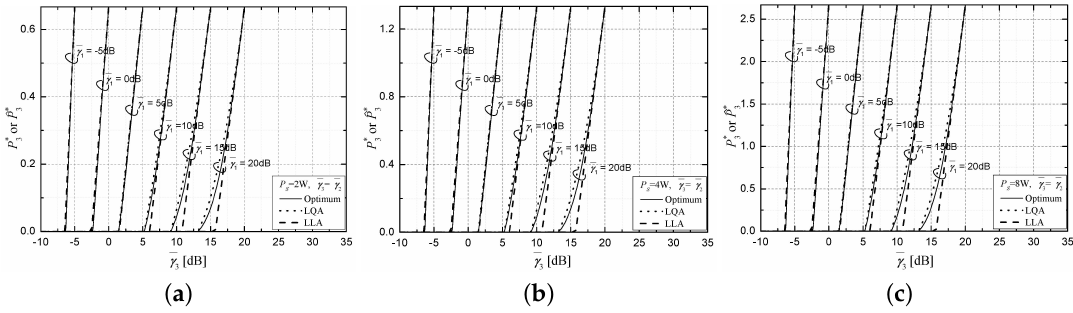
Figure 4. P ∗ versus ¯ γ 3 (= ¯ γ 2 )[dB], with ¯ γ 1 [dB] as a parameter: ( a ) P S = 2 W, ( b ) P S = 4 W, ( c ) P S = 8 3